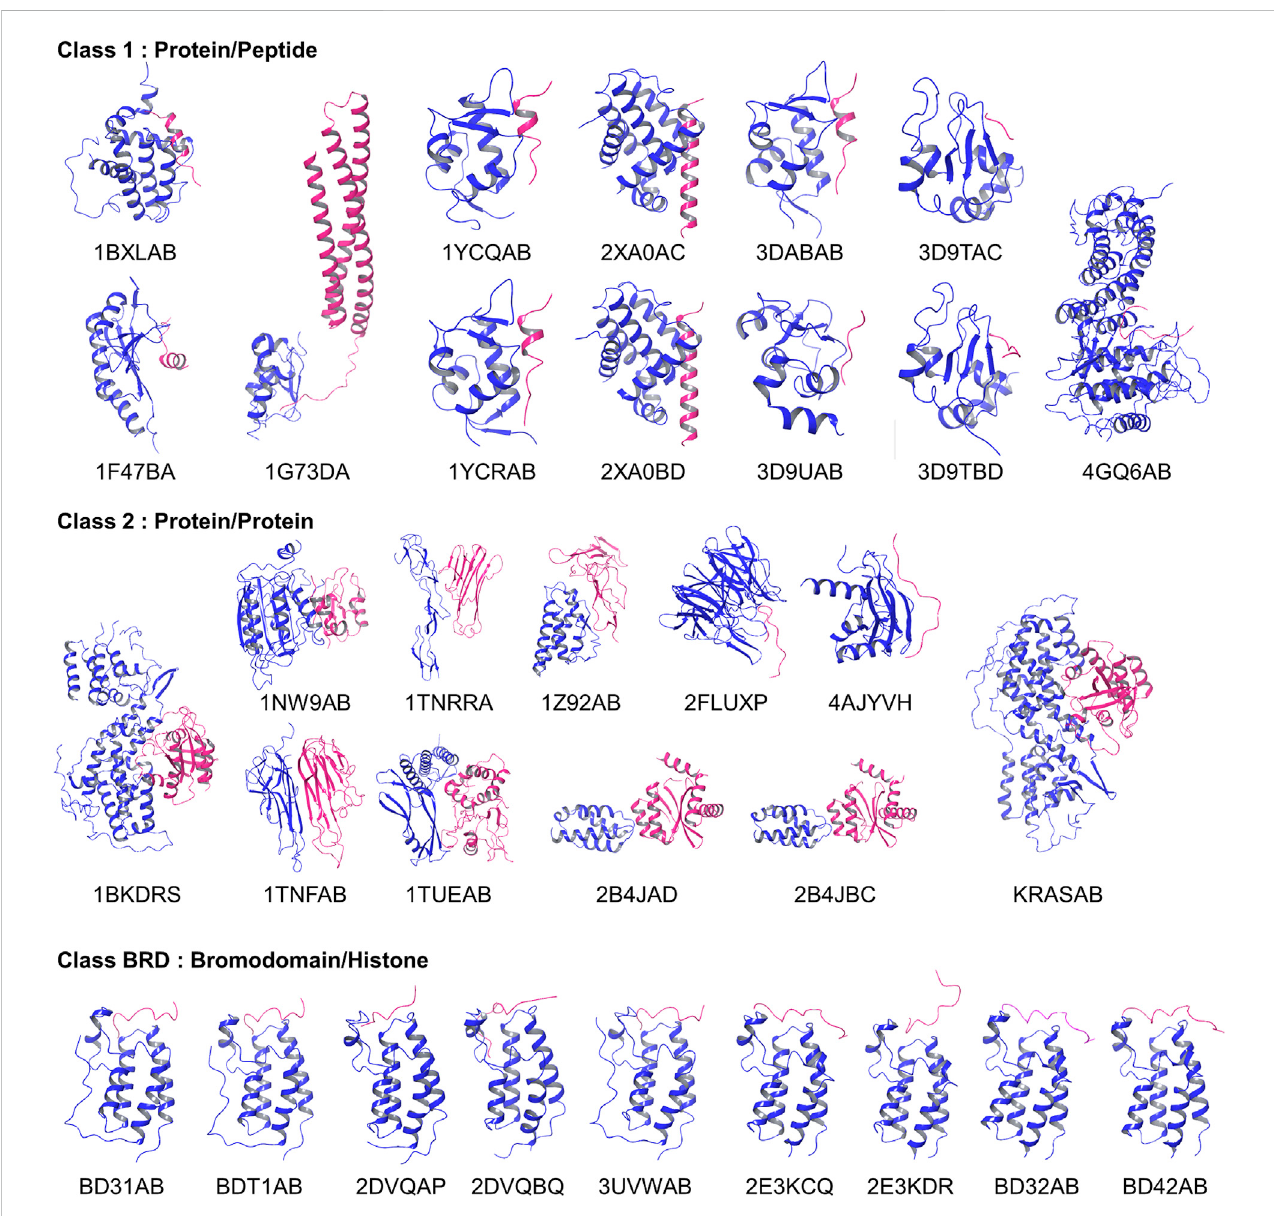
FIGURE 2 Entries in the 2P2I dataset. Proteins in blue were considered as receptors and their PPI surface were compared.